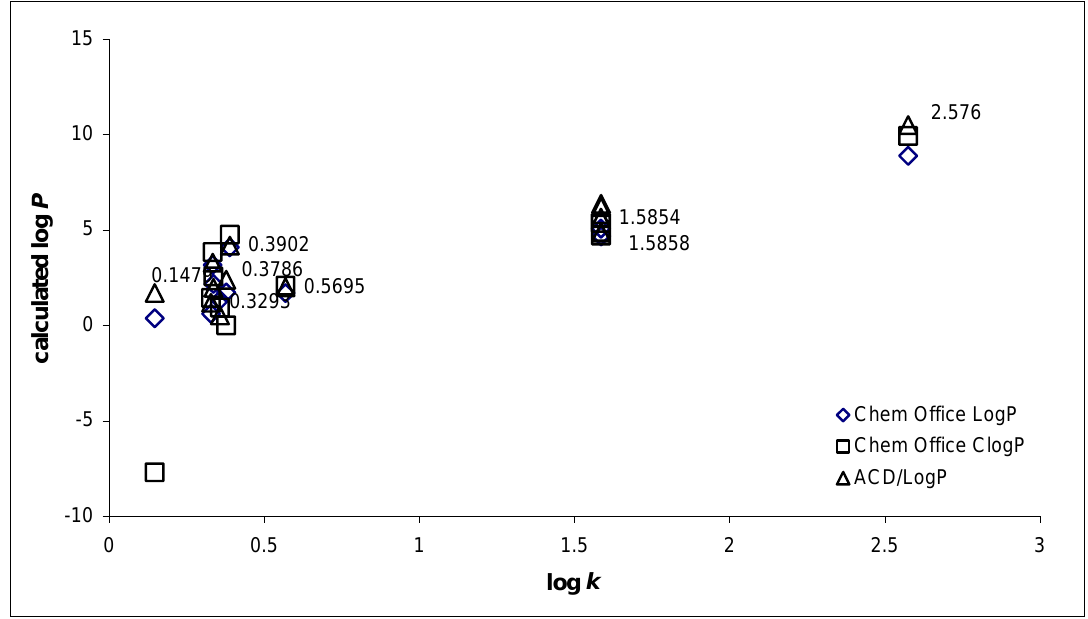
Figure 1. Comparison of the computed log P /Clog P values using two programs with the calculated log k